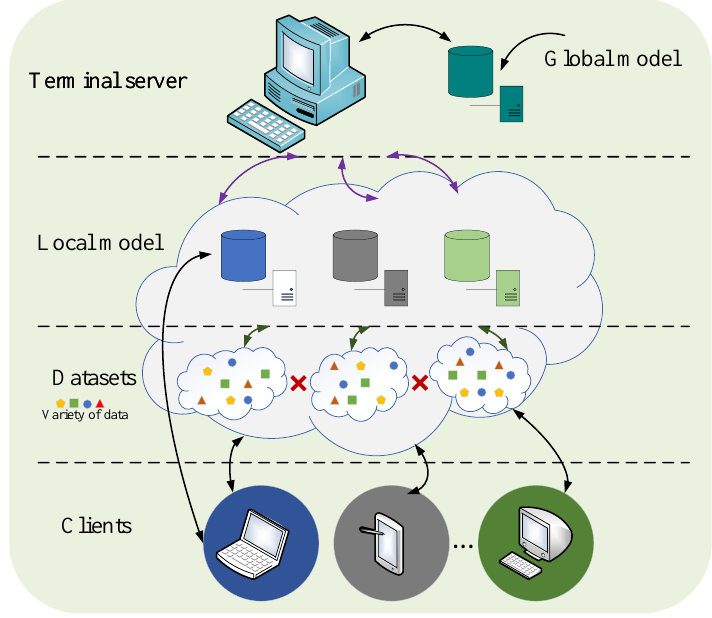
Figure 1. Algorithm framework of federated